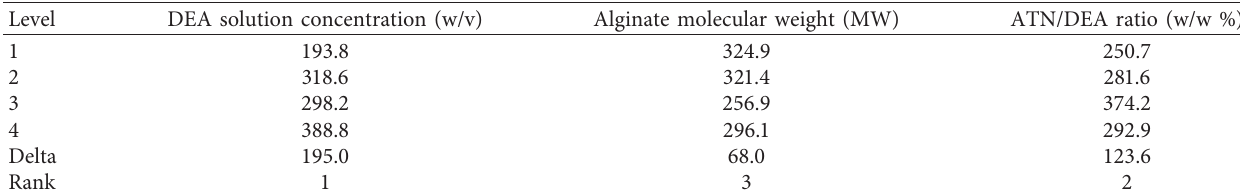
Table 3: Mean particle size responses with respect to process parameters and their